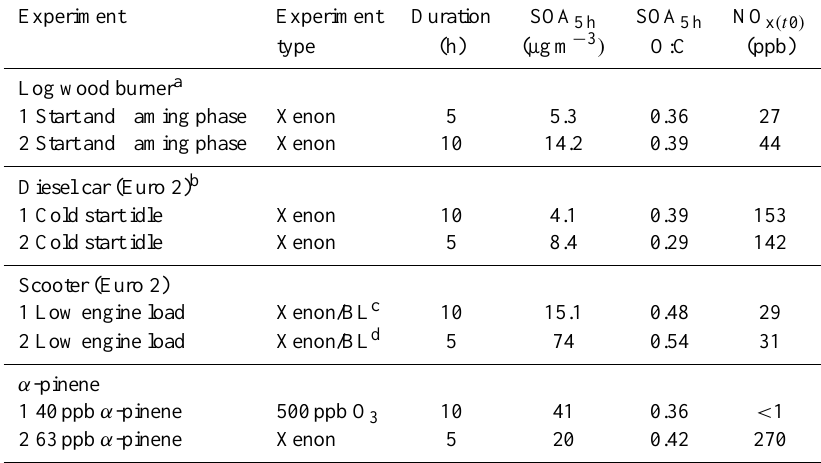
Table 1. Overview of the experimental parameters for the different smog chamber experiments. Experiment